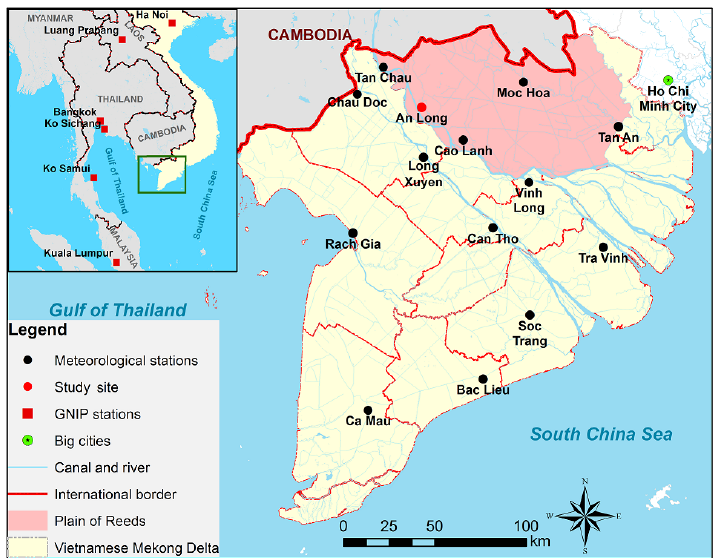
Figure 1. Sampling and monitoring sites in the study